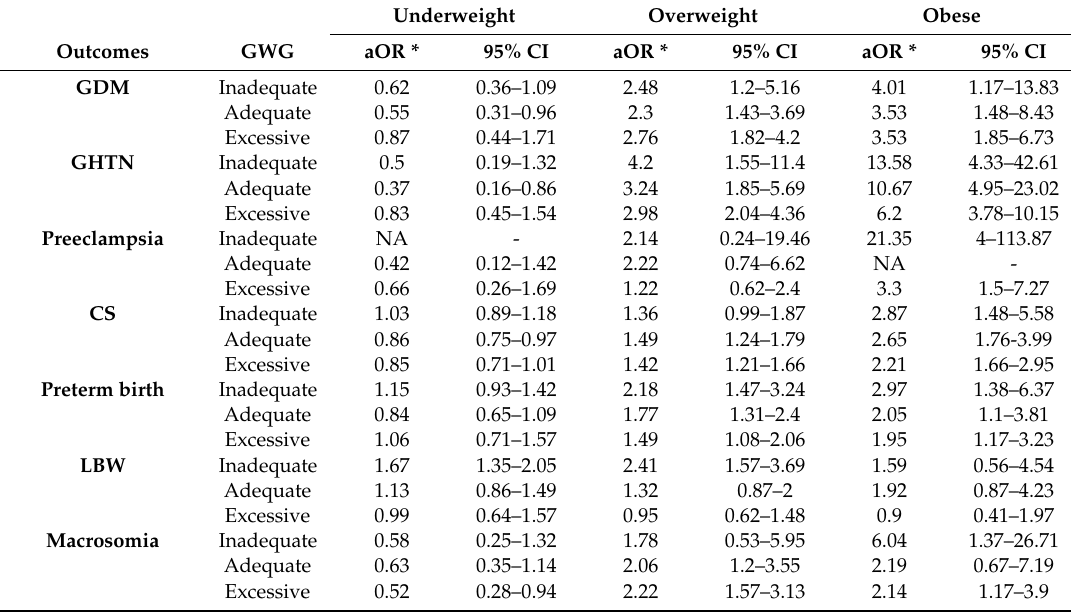
Table 4. Subgroup analysis of the association between prepregnancy body mass index (BMI) and risk of adverse perinatal outcomes by gestational weight gain